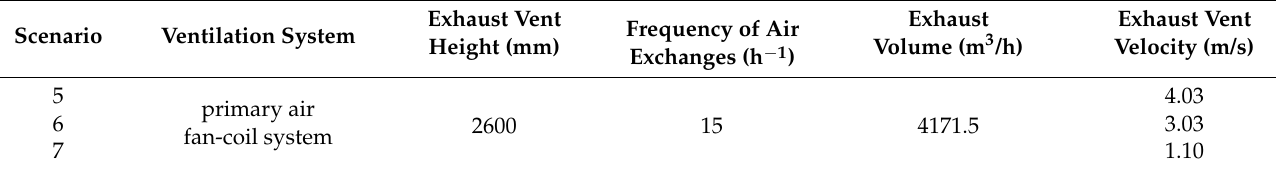
Table 7. Boundary conditions for air velocity at exhaust vent.